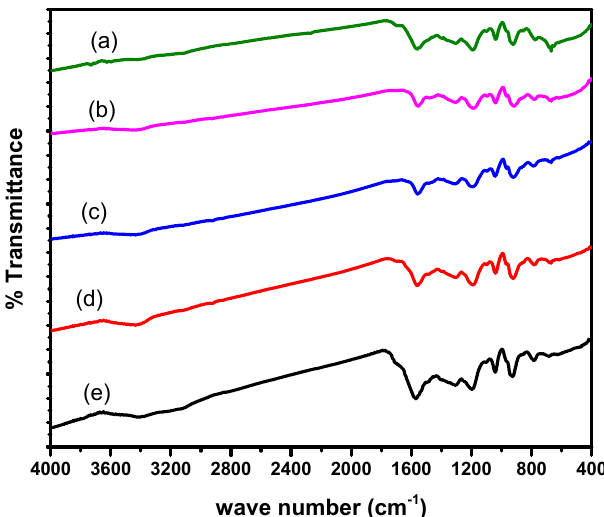
Figure 1. FT-IR spectrum of neat PPy and BaTiO 3.